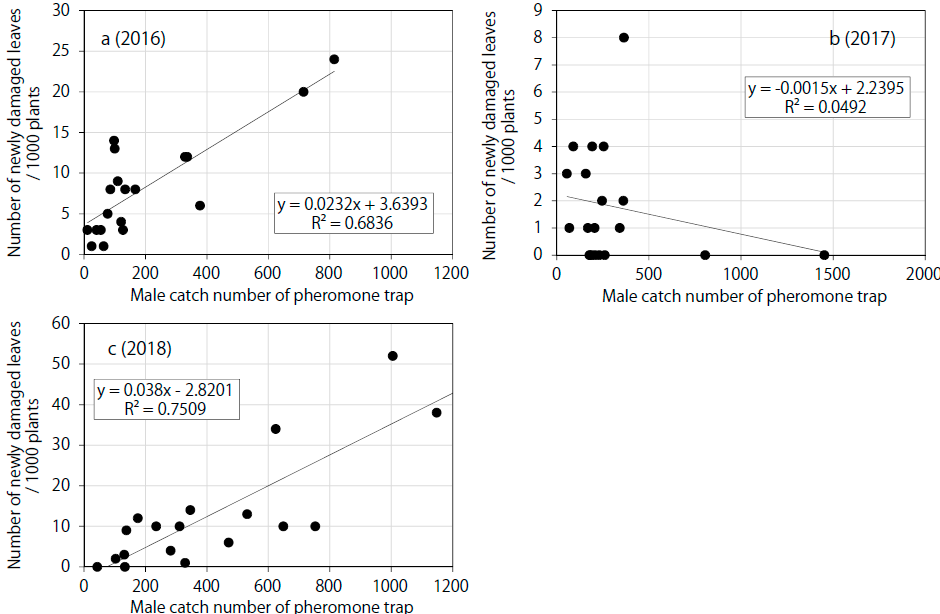
Figure 6. Linearity between the male catch number of the pheromone trap and the number of newly damaged leaves in August and September in ( a ) 2016 ( ds = 5, n = 19), ( b ) 2017 ( ds = 5, n = 17), and ( c ) 2018 ( ds = 5, n = 18).